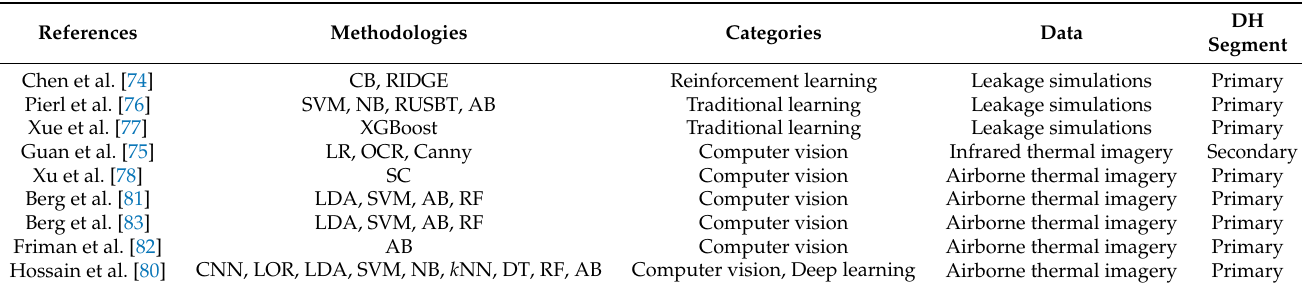
Table 5. Summary of applications of leakage detection